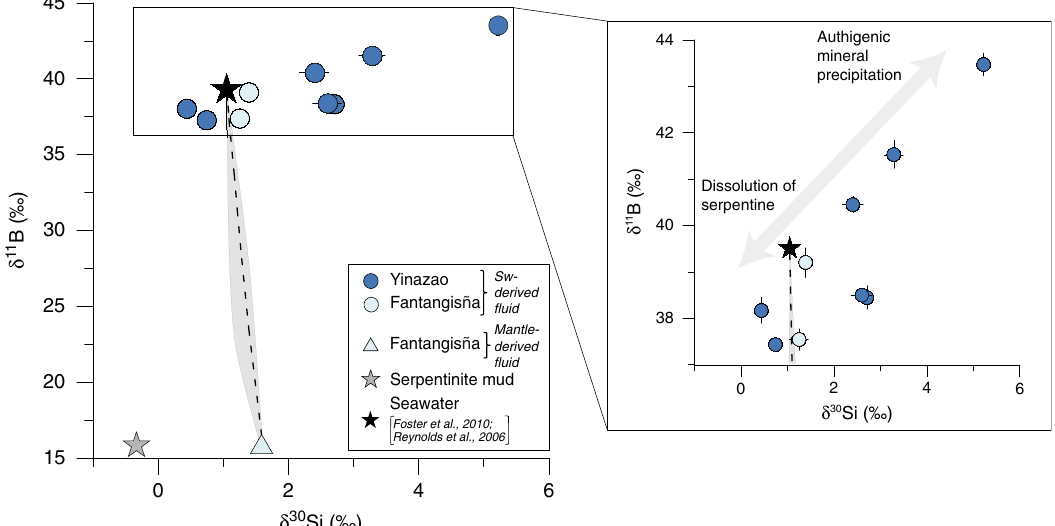
Fig. 2 Pore fl uid δ 11 B versus δ 30 Si values reveal different stages of silicate dissolution and Si precipitation. The mixing curve is calculated following Eq. (1) between seawater and a mantle-derived fl uid. The gray-shaded area takes the varying low Si concentrations of the mantle-derived fl uids into account (see section “ Methods ” , “ Mixing curve between seawater and a mantle-derived fl uid ” for details). Error bars (2 SD of individual measurements) not indicated are within symbol size. Note that the δ 30 Si value of the mantle-derived fl uid is likely affected by Si precipitation during fl uid ascent and that the data point from the serpentinite mud is derived from direct δ 30 Si measurements (Supplementary Table 2) and inferred for δ 11 B from pore fl uids given that no fractionation occurs during serpentinization (detailed in section “ Drivers of deep mantle-derived δ 30 Si and δ 11 B values ” ).